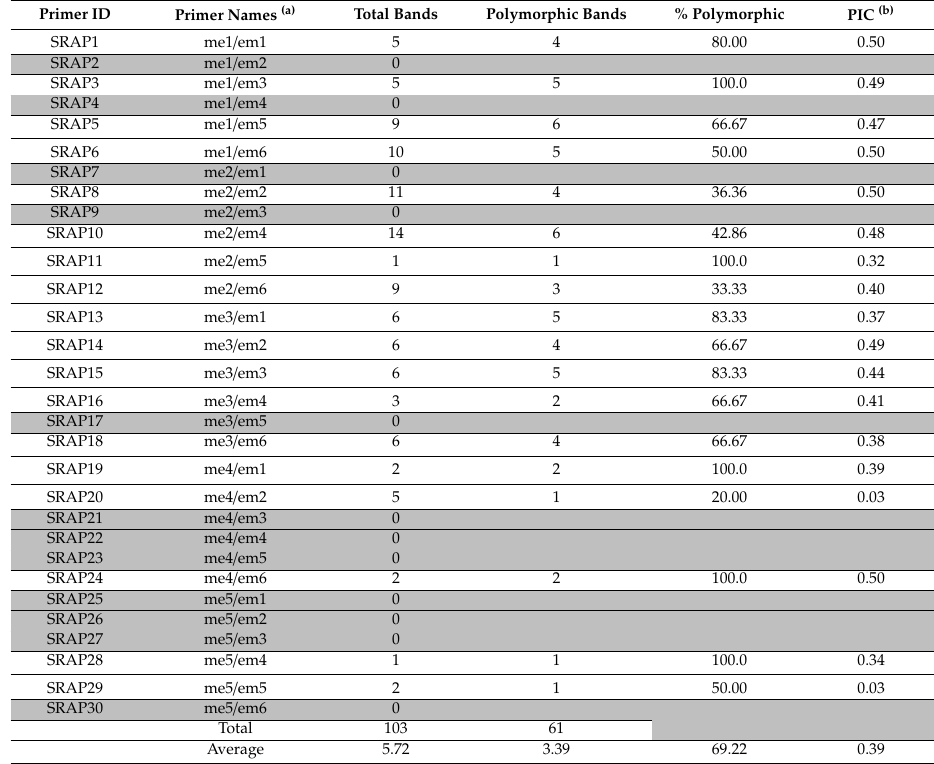
Table 3. Polymorphism in 59 rice blast strains revealed by sequence-related amplified polymorphism (SRAP) primer